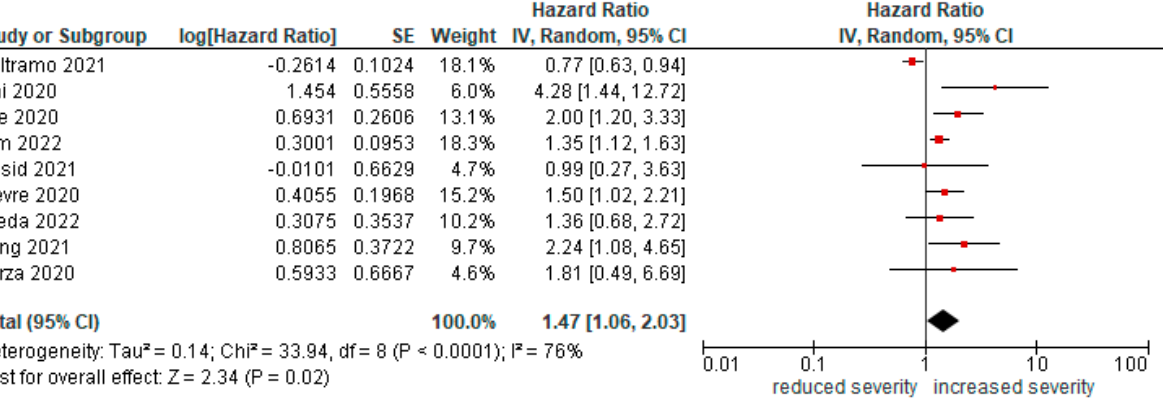
Figure 3. Forest plot for risk of severe infection in lung cancer patients.